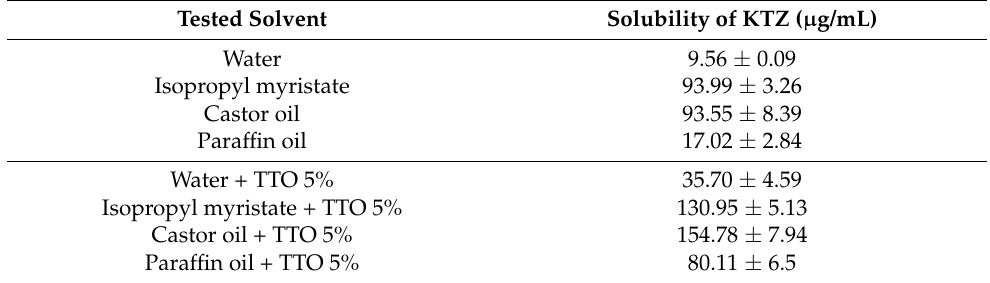
Table 1. Solubility of KTZ in chosen solvents. Values are expressed as means ± SD of six